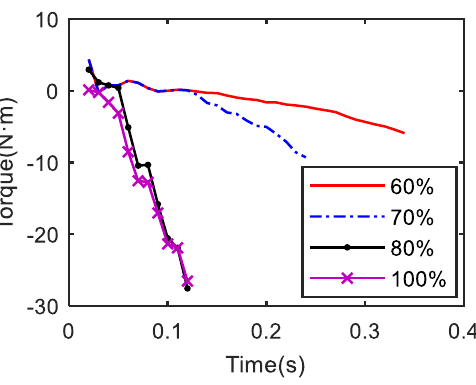
Figure 15. TB torque estimation results under different duty cycles of TB solenoid valve.